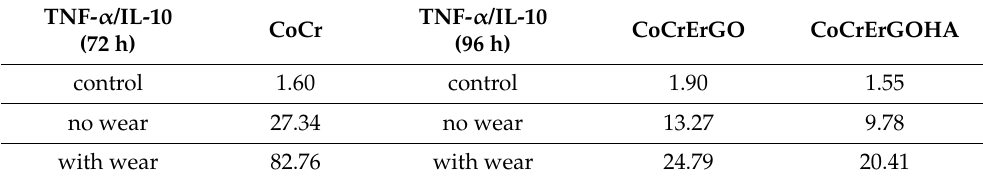
Table 2. TNF- α /IL-10 ratios of J774A.1 macrophage supernatants after being exposed for 72 h